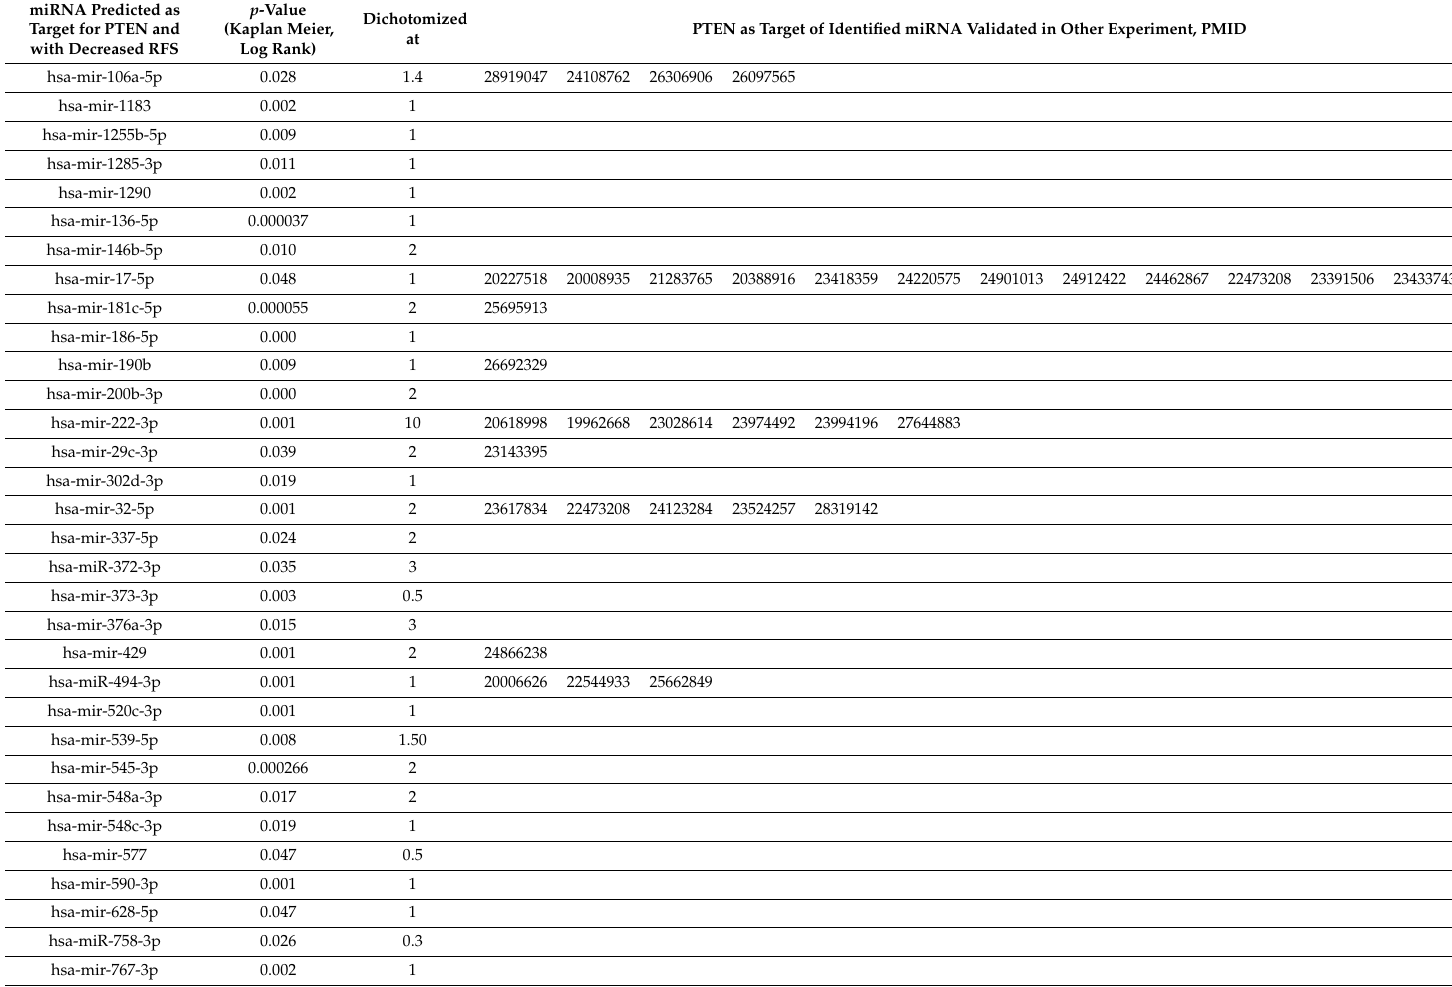
Table 3. MiRNA predicted as target for Phosphatase and tensin homolog (PTEN) and with decreased RFS and PMID of miRNA-PTEN interaction validated in other